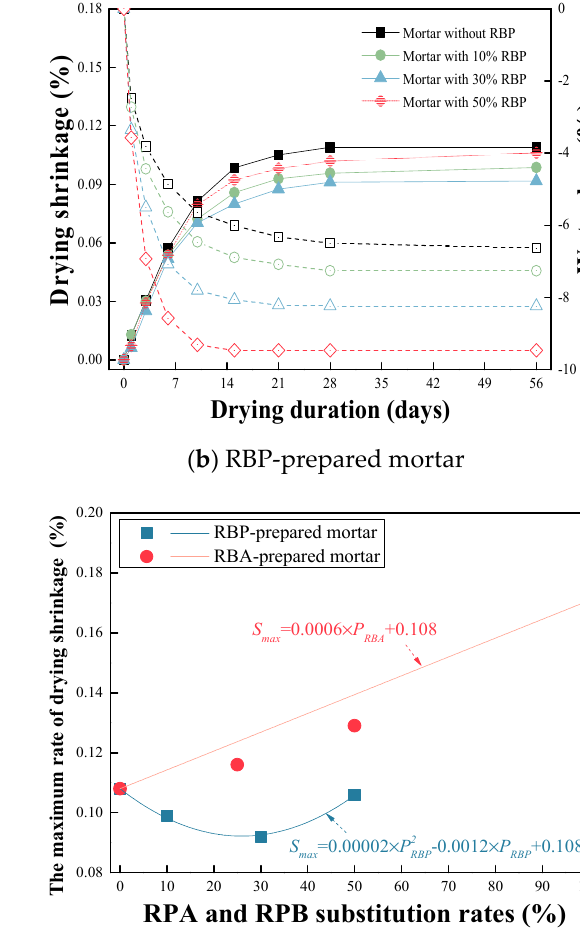
Figure 8. Fluidity and setting time of cementitious materials with various RBP substitution rates.